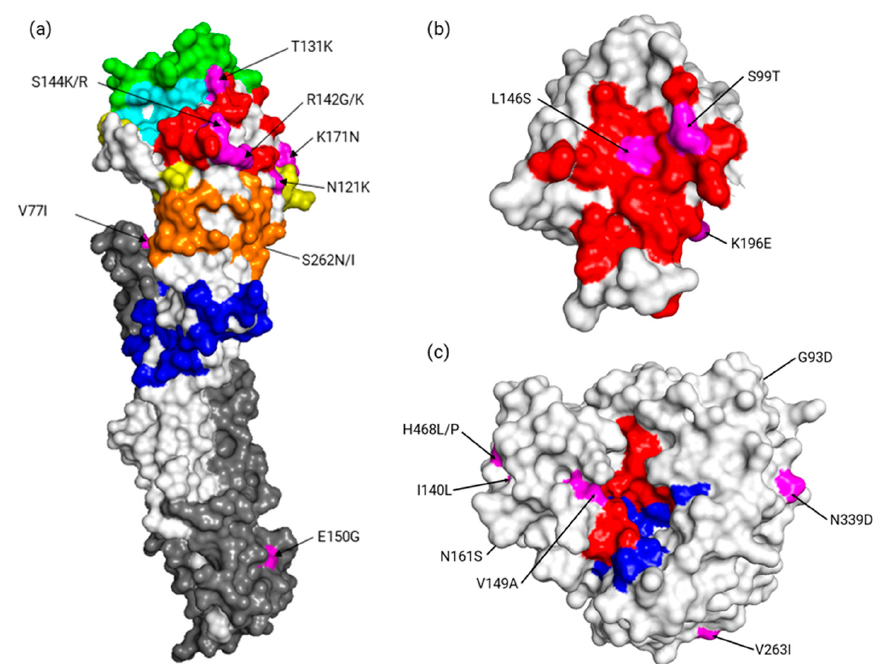
Figure 3. Contextualized locations of substitutions described in our study (in magenta). ( a ) On HA (PDB accession no. 4O5N) with antigenic sites A (red), B (green), C (blue), D (yellow), and E (orange) highlighted and the receptor binding site in cyan. ( b ) On NS1 (PDB accession no. 3EE8) with the p85 β -binding site colored red. ( c ) On NA (PDB accession no. 6BR6) with sialidase catalytic residues in red and framework residues in blue. The image was generated with PyMOL software (Delano Scientific, San Carlos, CA, USA).